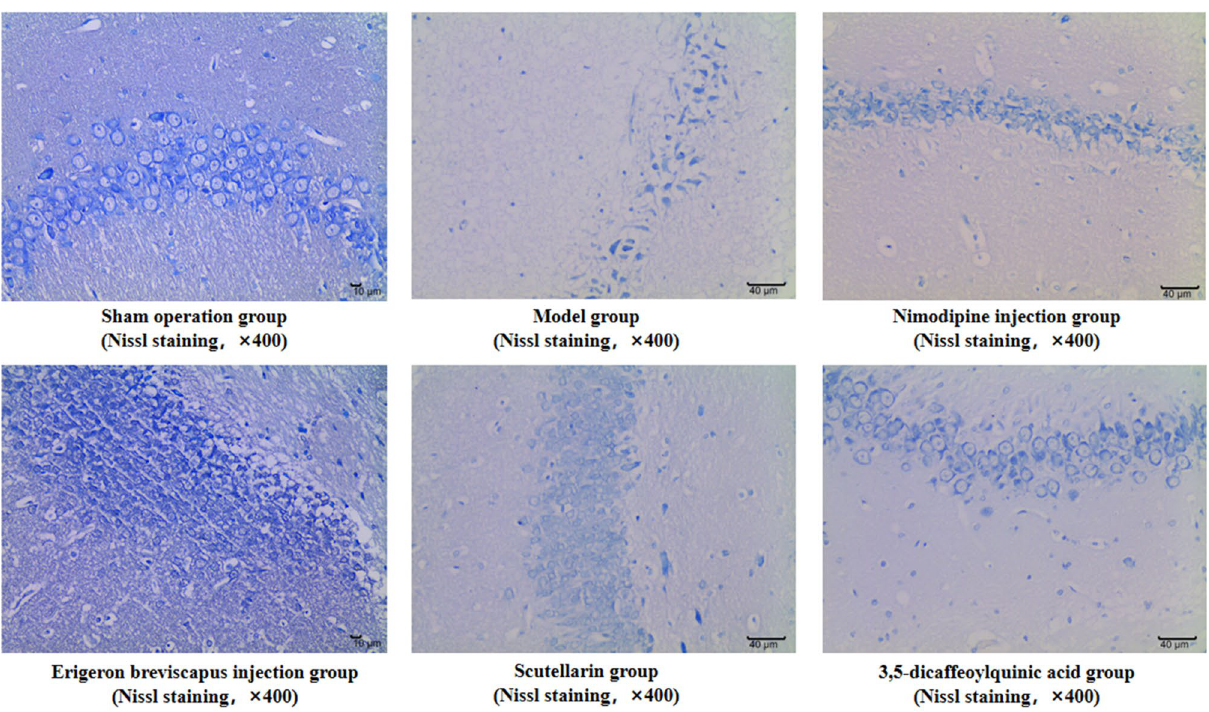
Figure 7. Nissl bodies in the ischemic brain tissue of rats: ① three visual fields were selected for each brain tissue to collect 400-fold images, and the mean value of each visual field was taken as the cell density of the sample after counting; ② the arrow indicates Nissl body. (Scale bar: Sham operation group − 10 μm; Model control group − 40 μm; Nimodipine injection group − 40 μm; E. breviscapus injection group − 10 μm; Scutellarin group − 40 μm; 3,5-dicaffeoylquinic group − 40